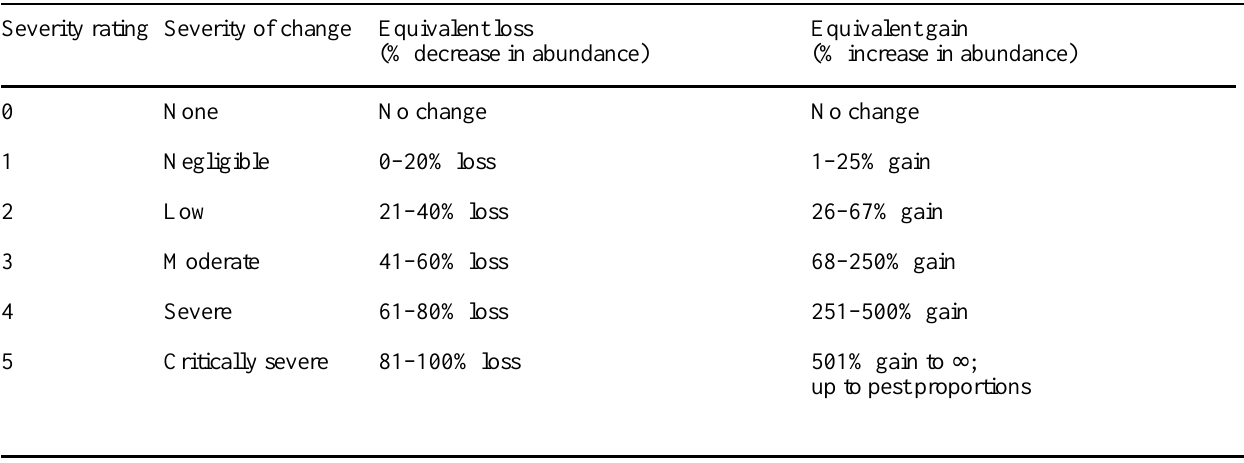
Table 9 . Severity ratings for predictions of change in abundance of biophysical features and a possible conversion to percentages (after King et al.